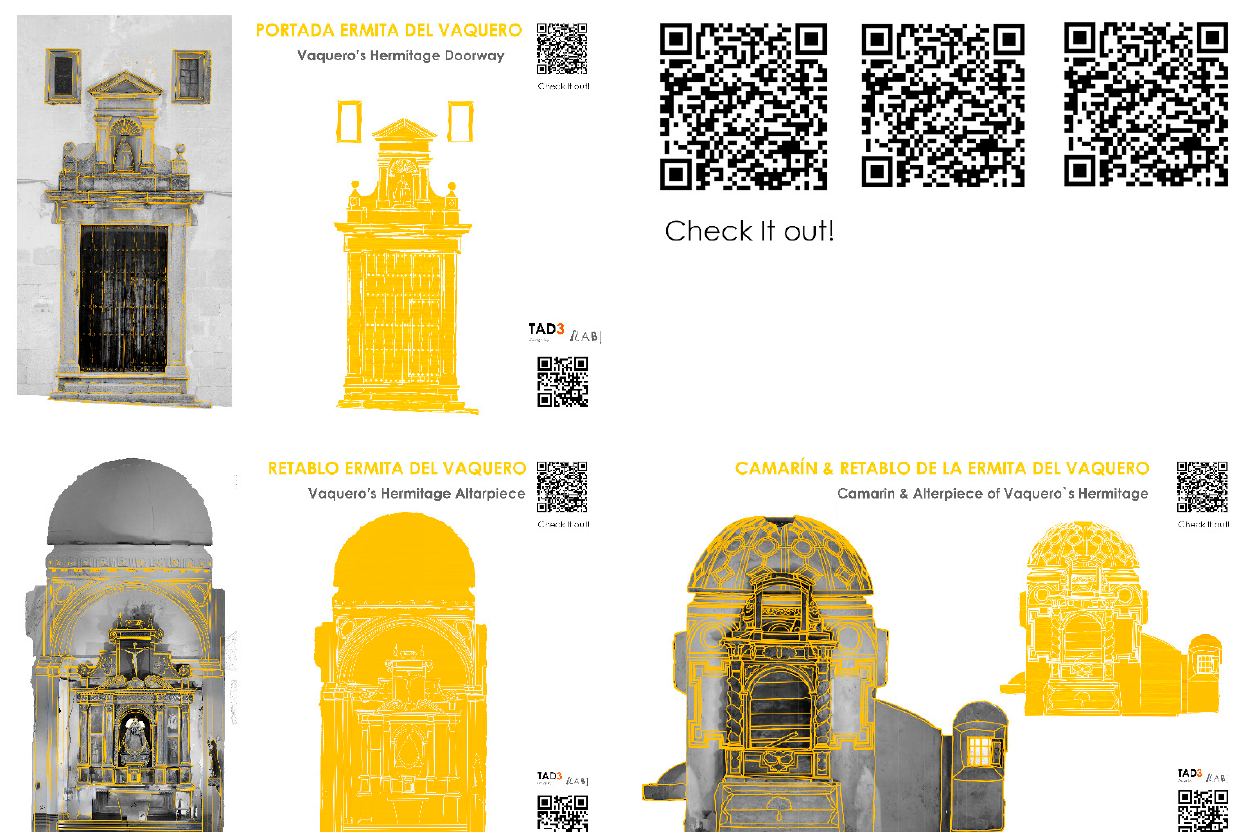
Figure 26. Tourist information proposal.